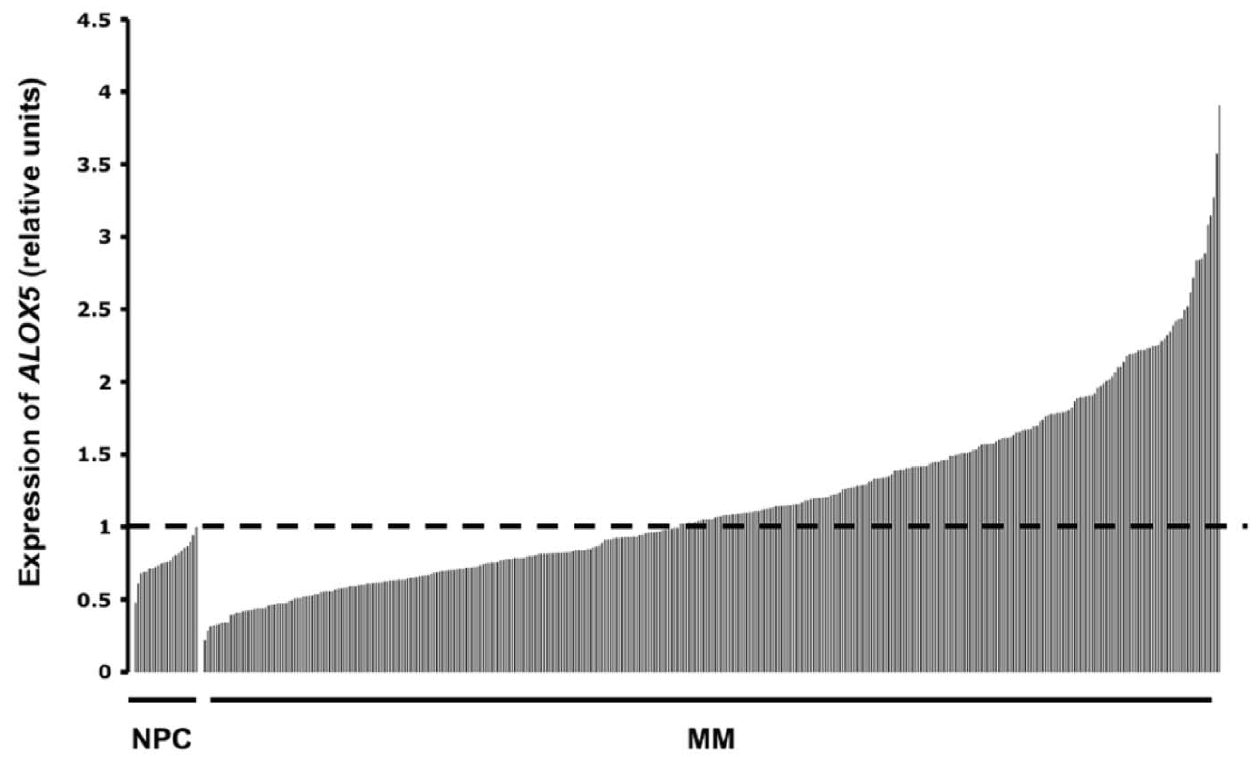
Figure 5. Expression of ALOX5 in MM Patients. Raw expression value was obtained from GEO GSE 2658 and 5900. The expression values for probes representing ALOX5 on the U133plus 2.0 chip were first log-transformed and median centered, and then a composite relative expression value for ALOX5 for each patient was obtained by taking the median expression across these probes. This relative expression value is represented on the Y axis. The expression value of 22 NPC and 351 newly diagnosed MM are highlighted ranked from low to high expression. The horizontal dotted line represents the mean + 2SD expression value among the NPC.